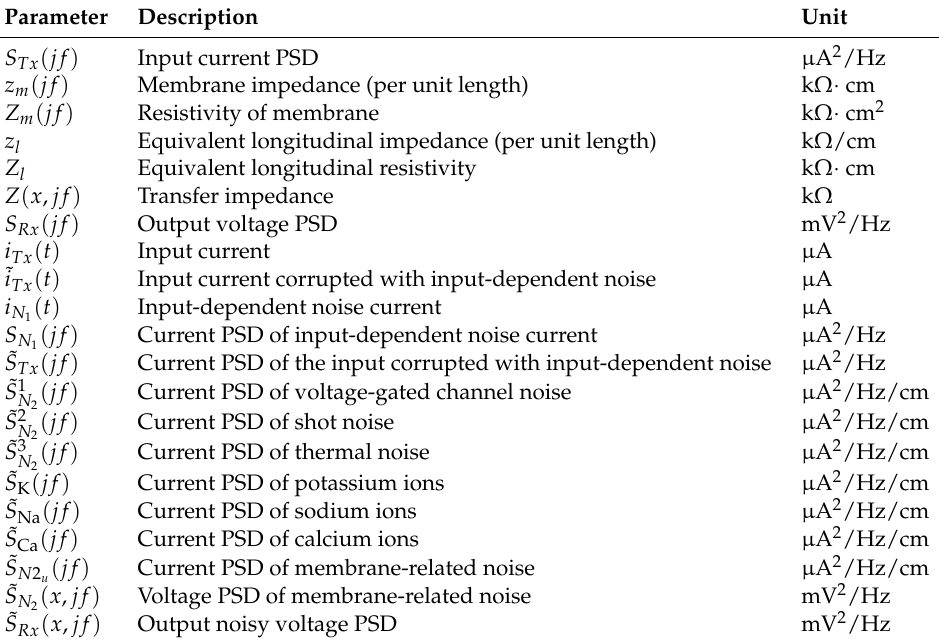
Table 1. Defined symbols used throughout the